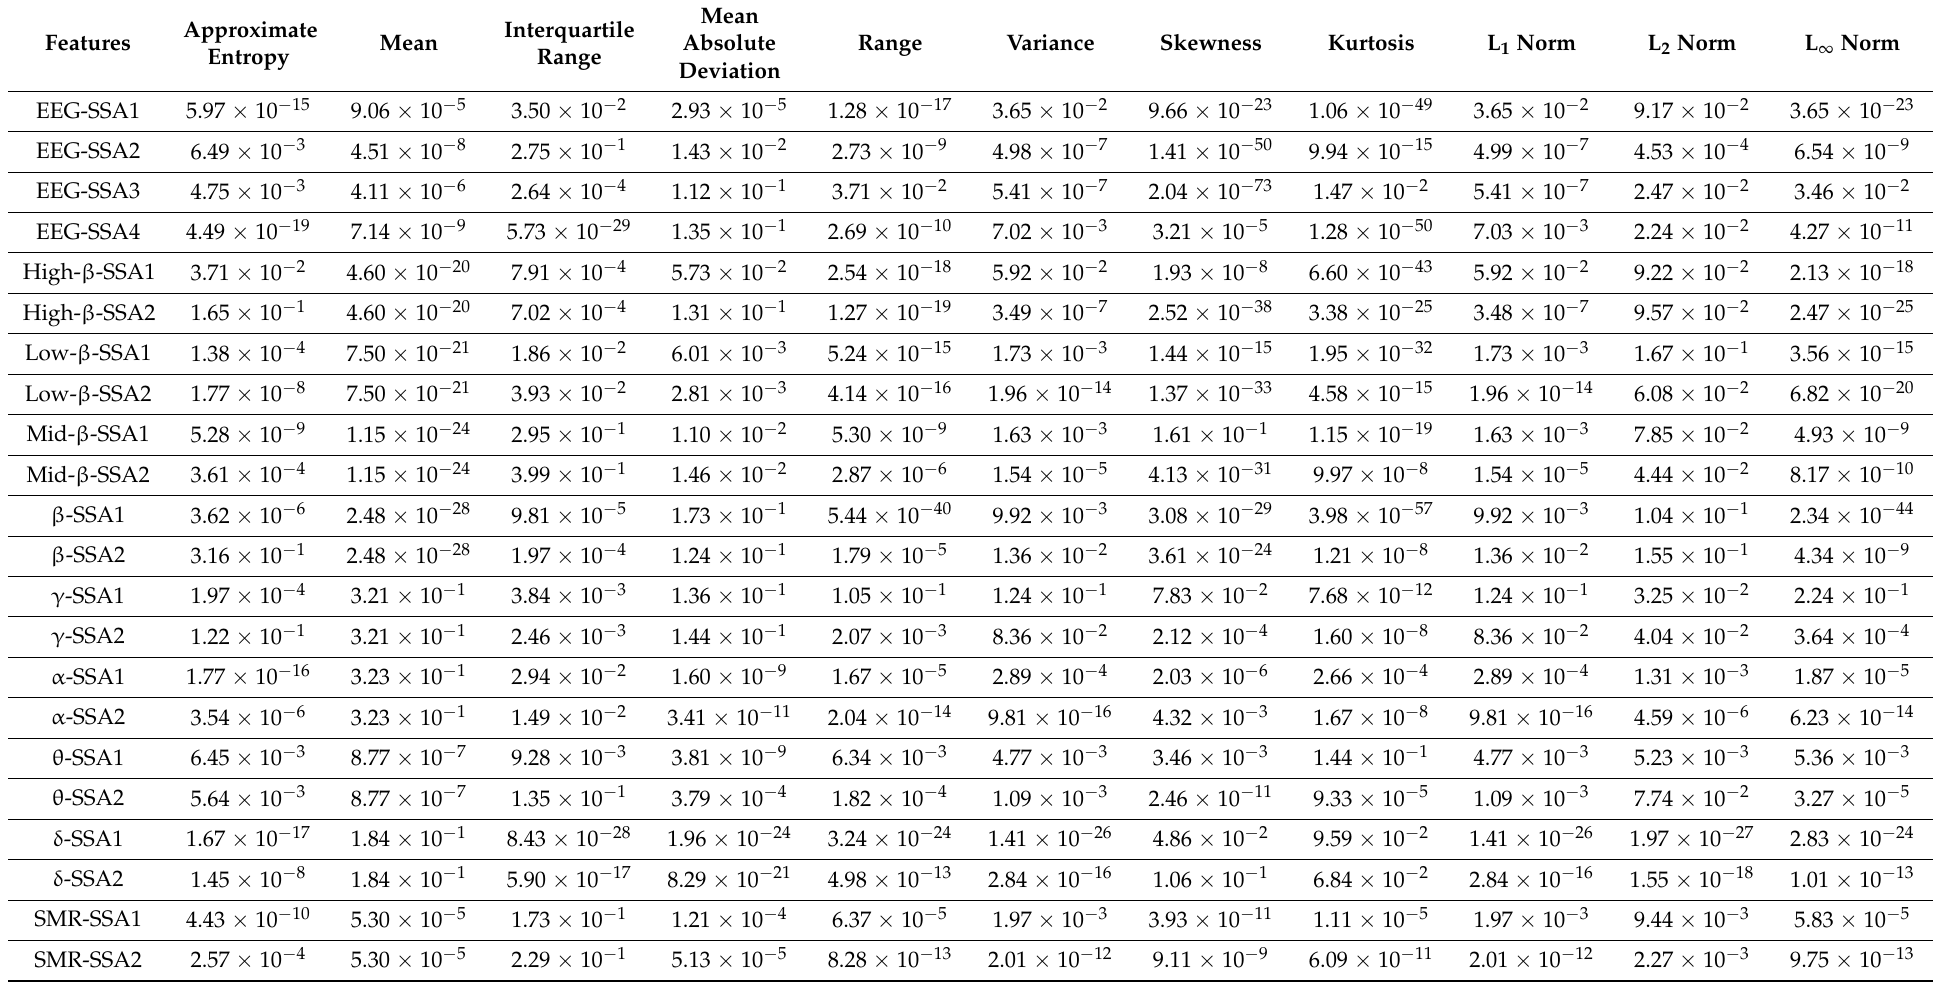
Table 4. The values of P corresponding to different features extracted from the SSA components of a detrended